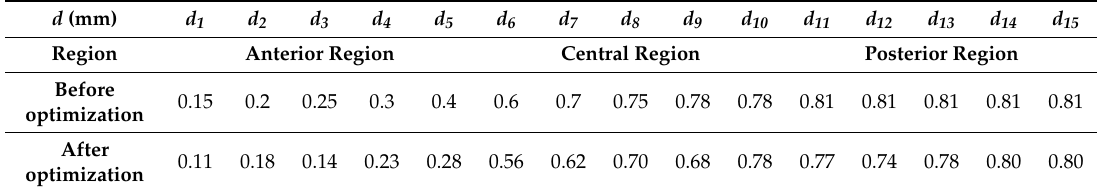
Table 4. Constraints of height variable d i in optimization process.